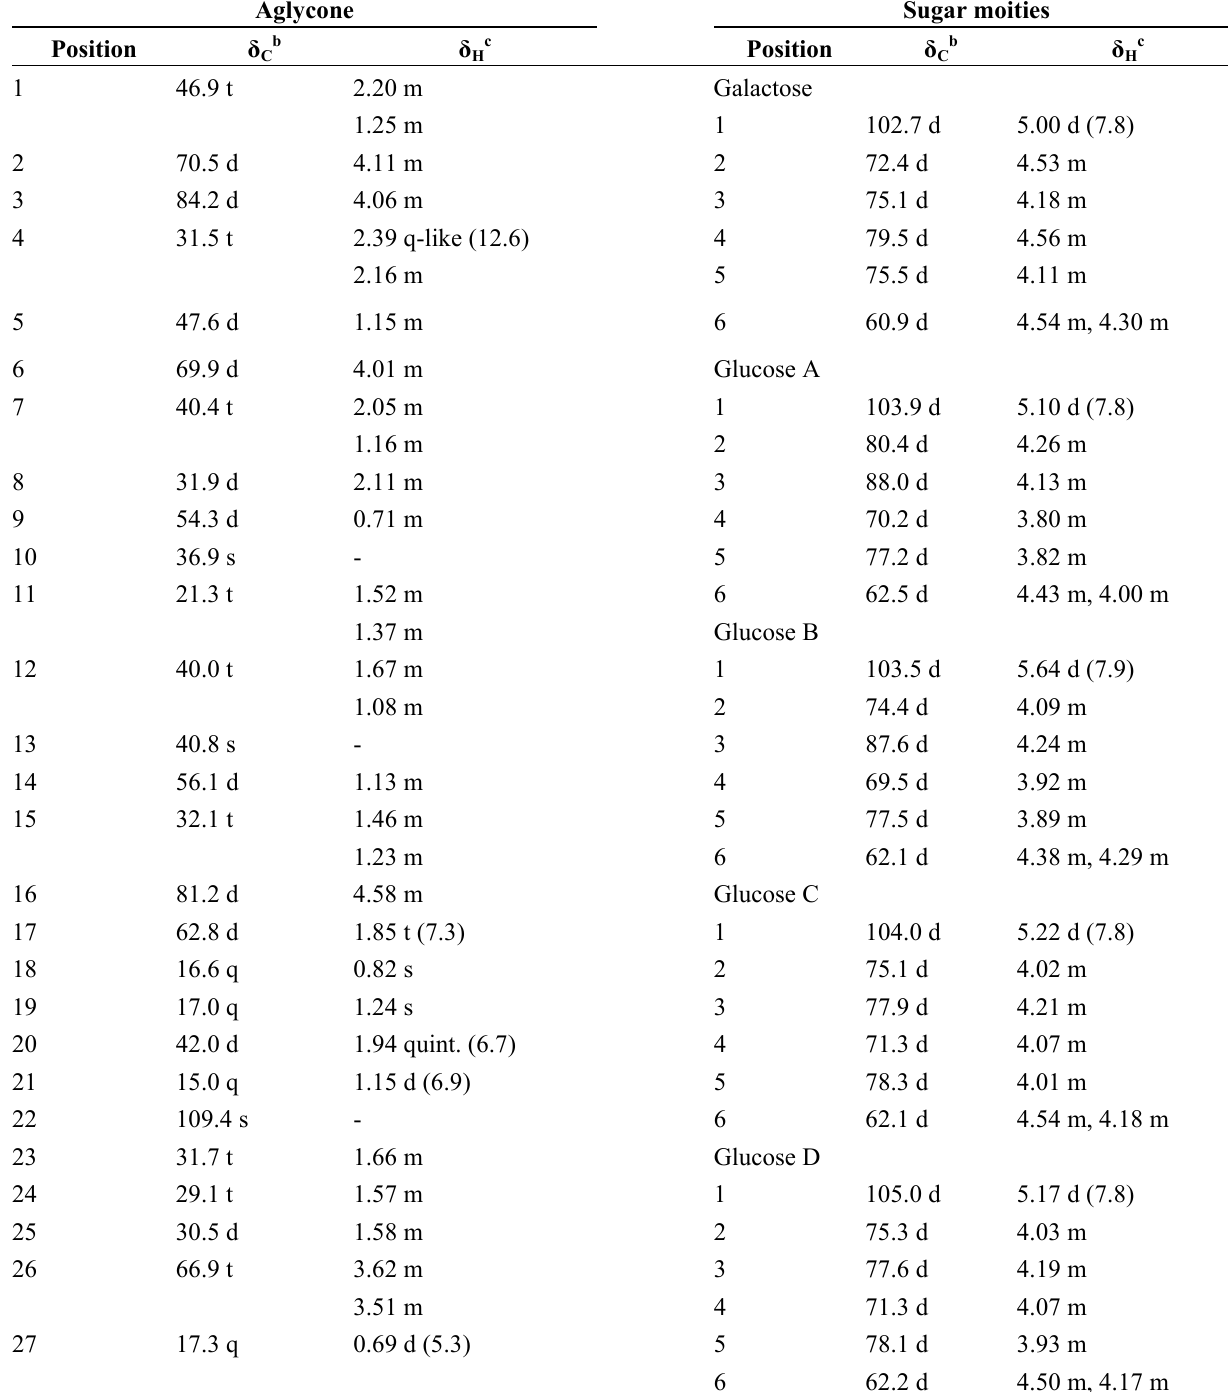
Table 2 . NMR spectroscopic data of compound 5 a